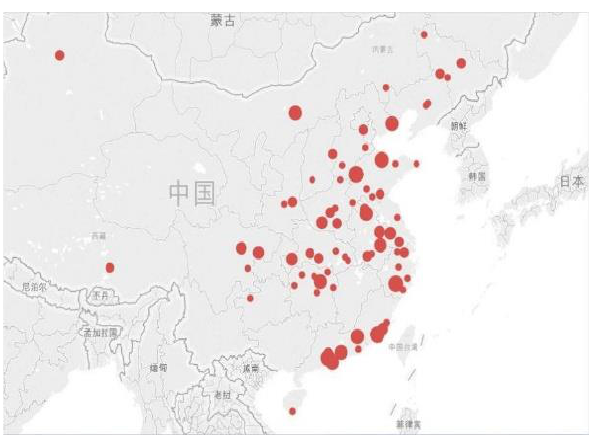
Fig.10 Geographical distribution (the number of